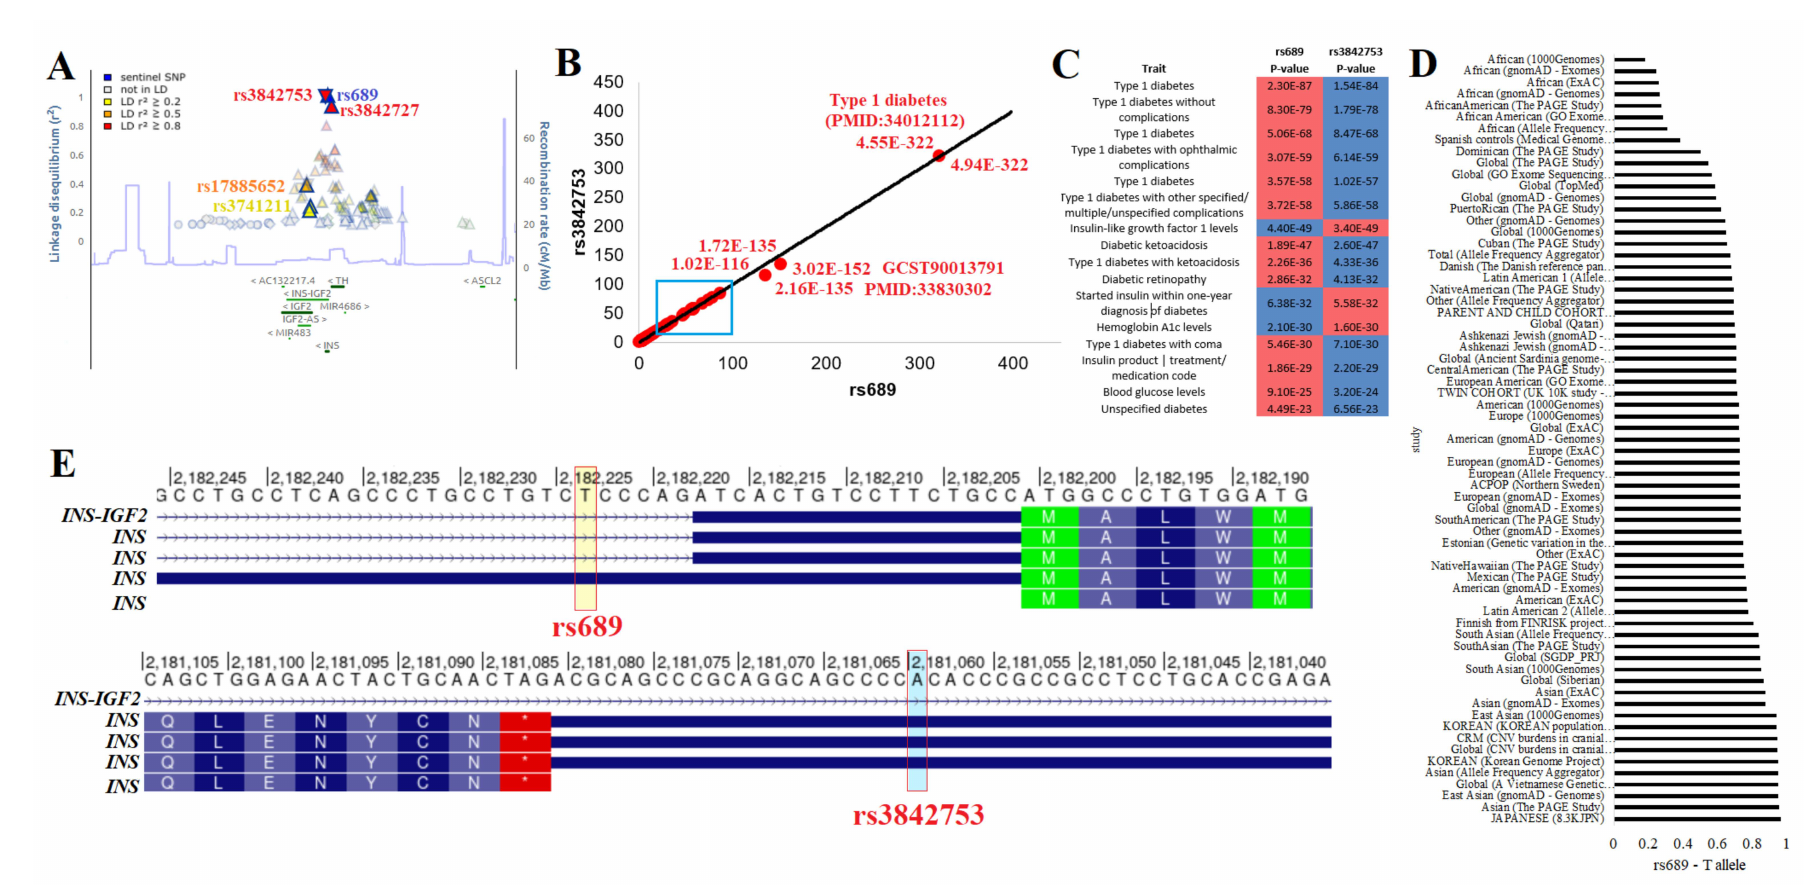
Figure 2. Top LD block for insulin and diabetes. ( A ) Linkage disequilibrium map of rs689, with other T1D associated SNPs labeled. Those in red have >0.8 R 2 with rs689, orange, >0.5 R 2 , and yellow, >0.2 R 2 . Shown below is the location of genes with green lines representing the gene location. The blue line represents the recombination rates across the region. ( B ) Open Target Genetics extracted − log10 p -values from various associations for rs689 (x-axis) relative to rs3842753. The black line shows a 1-to-1 relationship. ( C ) p -values are shown for various traits in the Panel B cyan box for both SNPs. The more significant values are shown in red. ( D ) The rs689 T allele frequency from various genomic datasets ranked from lowest to most frequent. ( E ) The genomic location (hg19) for rs689 and rs3842753 relative to transcripts of INS . Amino acids are labeled in boxes, the UTRs are represented as blue lines, and the intron segments are represented with arrowed